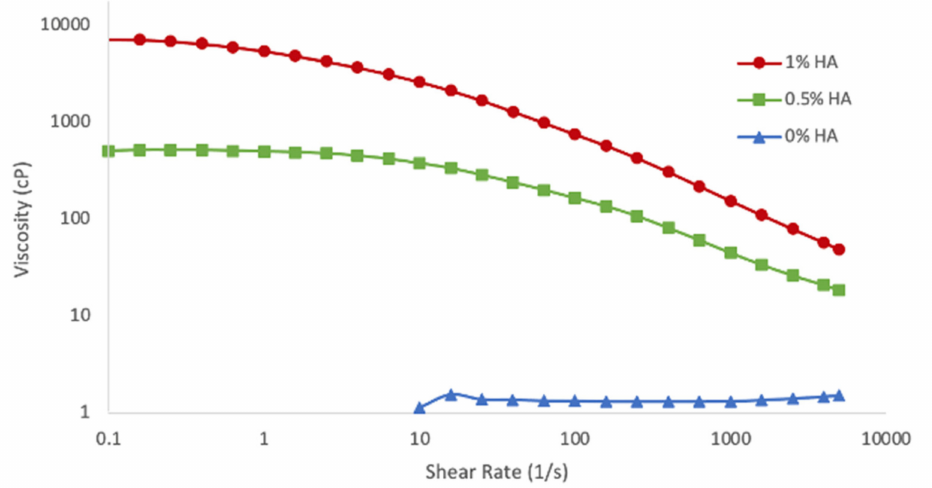
Figure 3. Effect of HA concentration with ASL on viscosity vs. shear